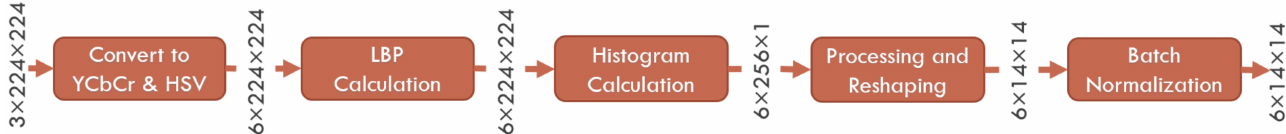
Figure 6. Texture Analysis Block Diagram.